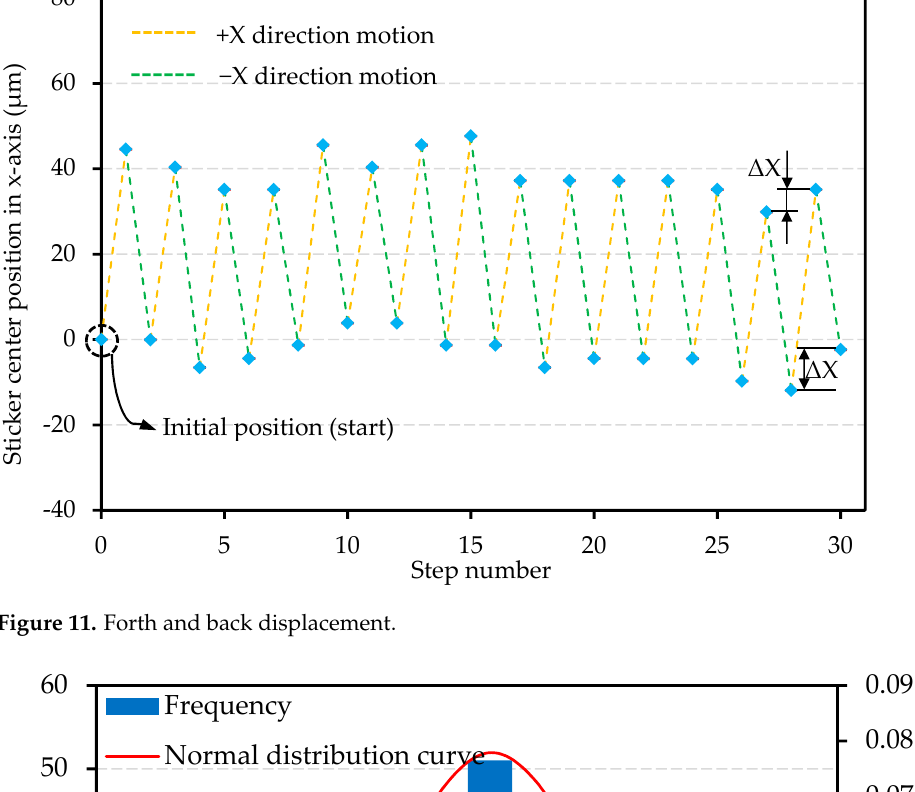
Figure 11. Forth and back displacement.